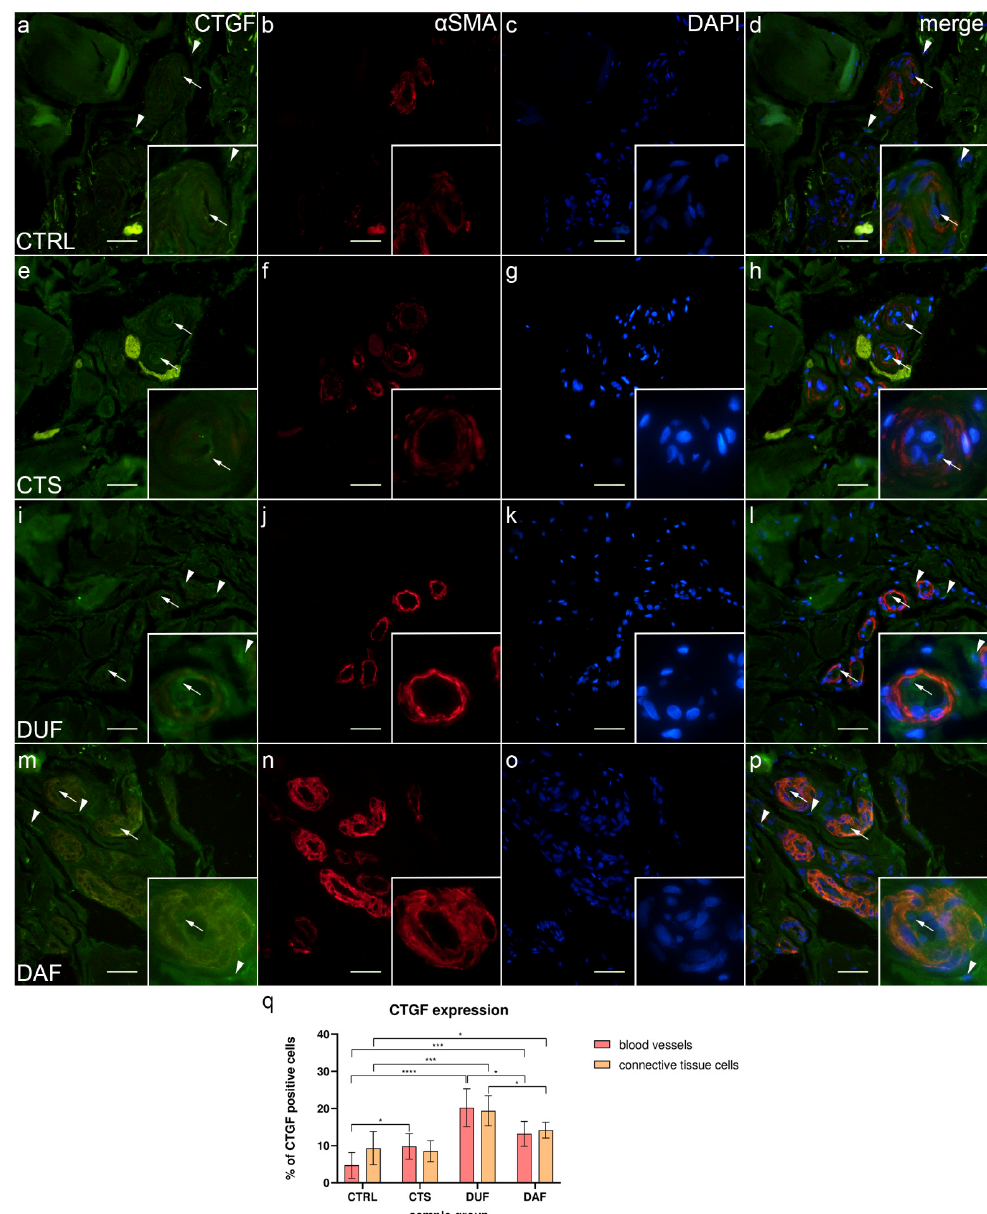
Figure 6. Co-expression of CTGF and α -SMA in connective tissues of patients with CTS and DD. CTRL–palmar fascia of CTS patients ( a – d ); RF–flexor retinaculum of CTS patients ( e – h ); DUF–clinically unaffected palmar fascia of DD patients ( i – l ); DAF–clinically affected palmar fas- cia of DD patients ( m – p ). CTGF expression ( a , d , e , h , i , l , m , p ) is seen in blood vessels (arrows) and surrounding connective tissue cells (arrowheads); α -SMA staining shows sections through blood vessels ( b,f,j,n ). DAPI staining displays all cell nuclei ( c , g , k , o ). Insets ( a – p ) reveal the distribution of CTGF staining in blood vessels. Double immunofluorescence staining to CTGF, α -SMA, and DAPI, 400 × magnification, scale bar 100 µ m. The graph displays statistically significant differences in CTGF expression of blood vessel and connective tissue cells ( q ). Error bars show standard deviation; * p < 0.05, *** p < 0.001, **** p < 0.001. The expression of CTGF in blood vessels of control samples (4.70% ± 3.47%) was significantly lower compared to CTS (9.80% ± 3.46%; p = 0.023; d = 1.473), DUF (20.20% ± 5.16%; p < 0.0001; d = 3.526), and DAF samples (13.20% ± 3.36%; p = 0.0002; d = 2.490). Connective tissue cell CTGF expression was also significantly lower in control